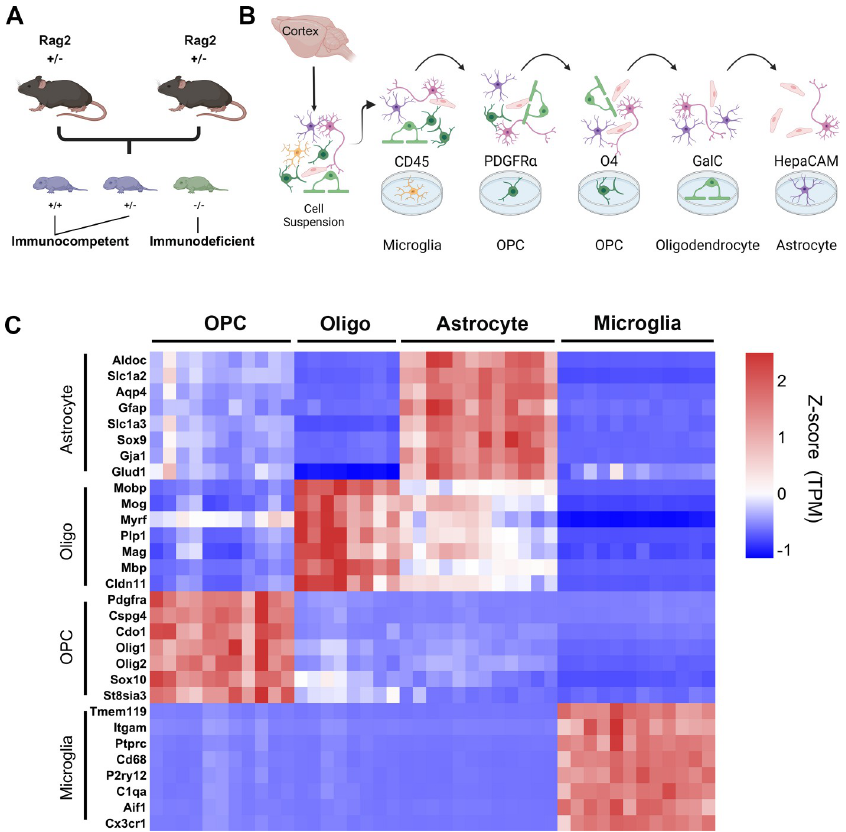
Fig 1. Acute purification of glial cell populations from immunodeficient mice. A) Breeding schematic; Rag2 +/- parents bore offspring that were immunocompetent (Rag2 +/+ and Rag2 +/- ) or immunodeficient (Rag2 -/- ). All immunodeficient mice and littermate controls were maintained in the same environment. B) Immunopanning schematic; a single-cell suspension was generated from the cerebral cortex, then passed over a series of plates coated with cell type specific antibodies to enrich for specific glial cell populations. C) Heatmap showing enrichment of cell- specific markers (rows) among the glial samples that we harvested and sequenced (columns); gene expression is quantified as transcripts per million (TPM), and each gene was further normalized to a z-score, defined as (expression in the sample—the average expression across all samples)/standard deviation; i . e ., the number of standard deviations from the